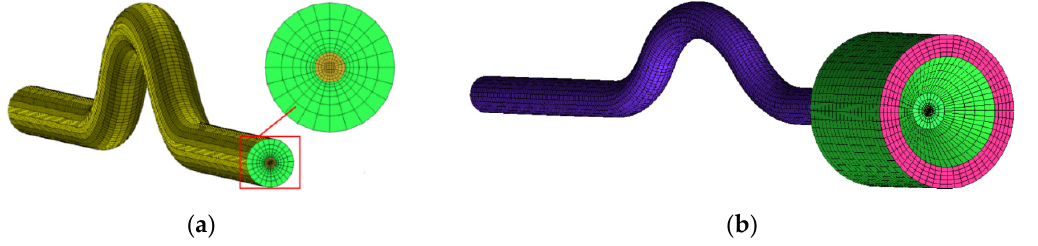
Figure 3. ( a ) Local enlargement of capillary meshing; ( b ) capillary meshing.